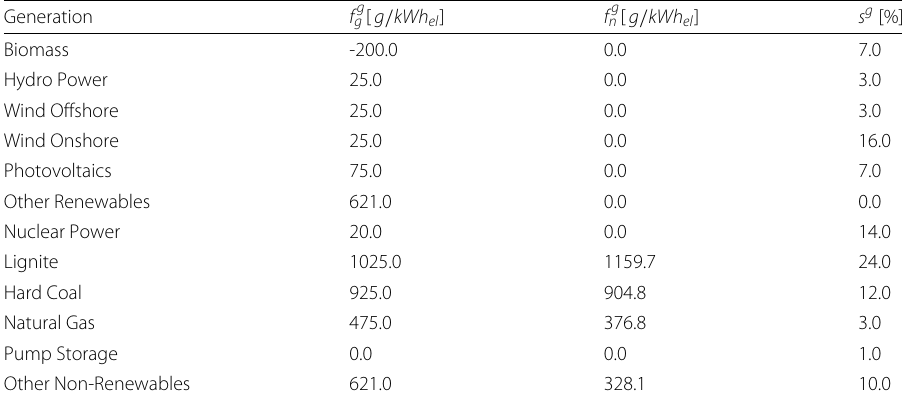
Table 1 CO 2 gross and net emission factors f g and generation shares s g of electricity generation technologies in Germany 2017 taken from Wagner et al. (2007), Ensslen et al. (2017), and statista.com